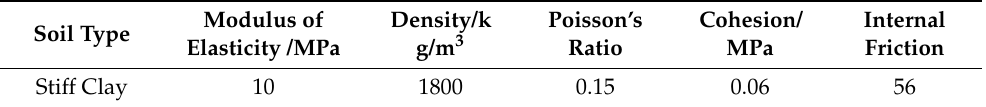
Table 1. Physical parameters of